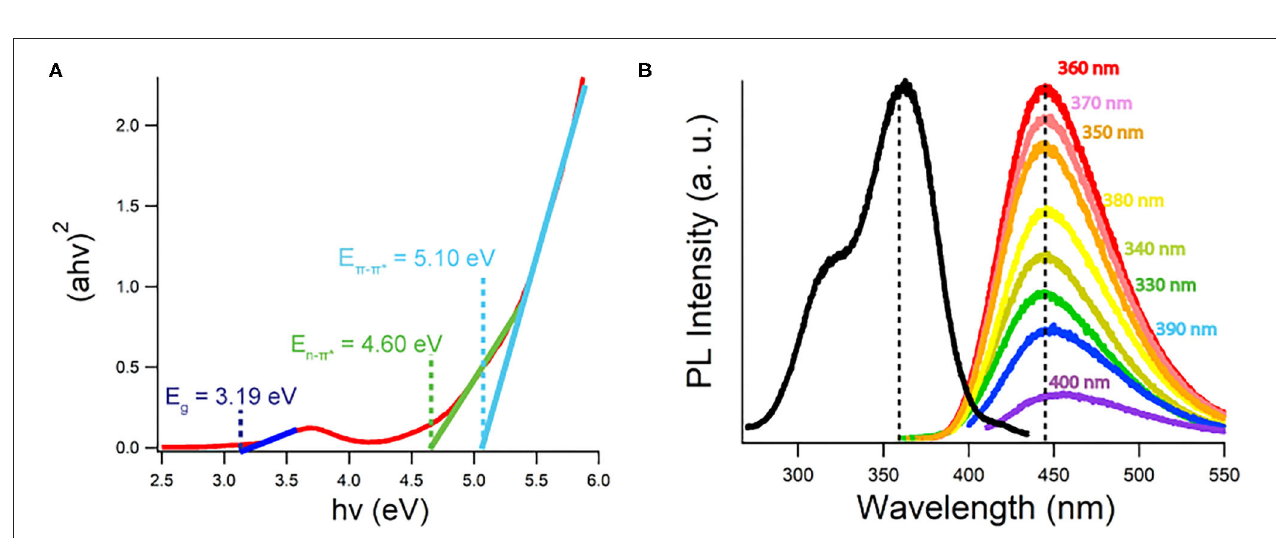
FIGURE 3 | (A) Tauc plot generated from 5 g/L CQD10 UV-Vis absorption data created with a direct band gap ( r = ½ ). (B) Photoluminescence spectra of 5 g/L of CQD10 in water dispersion at excitation wavelengths listed. Black scan measures 440nm PL intensity vs. excitation wavelengths.